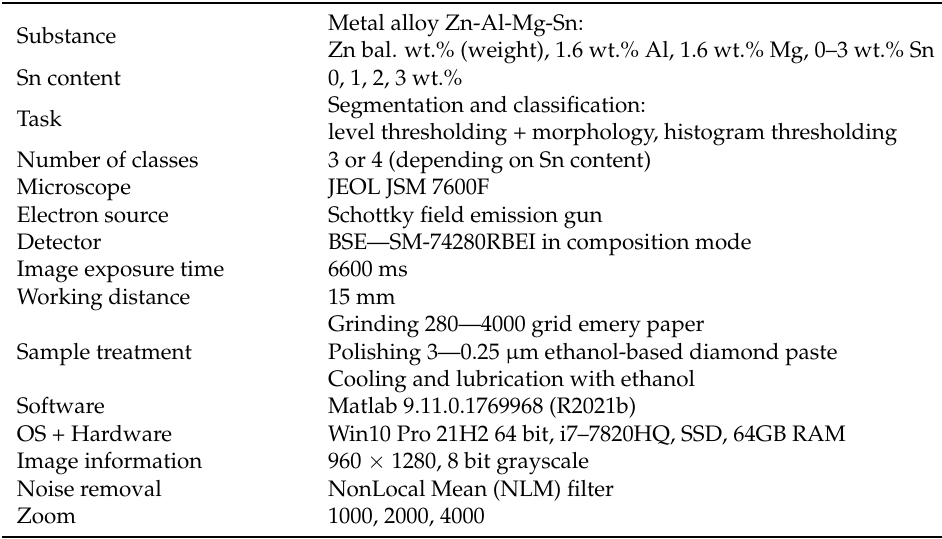
Table 3. Summary description of the